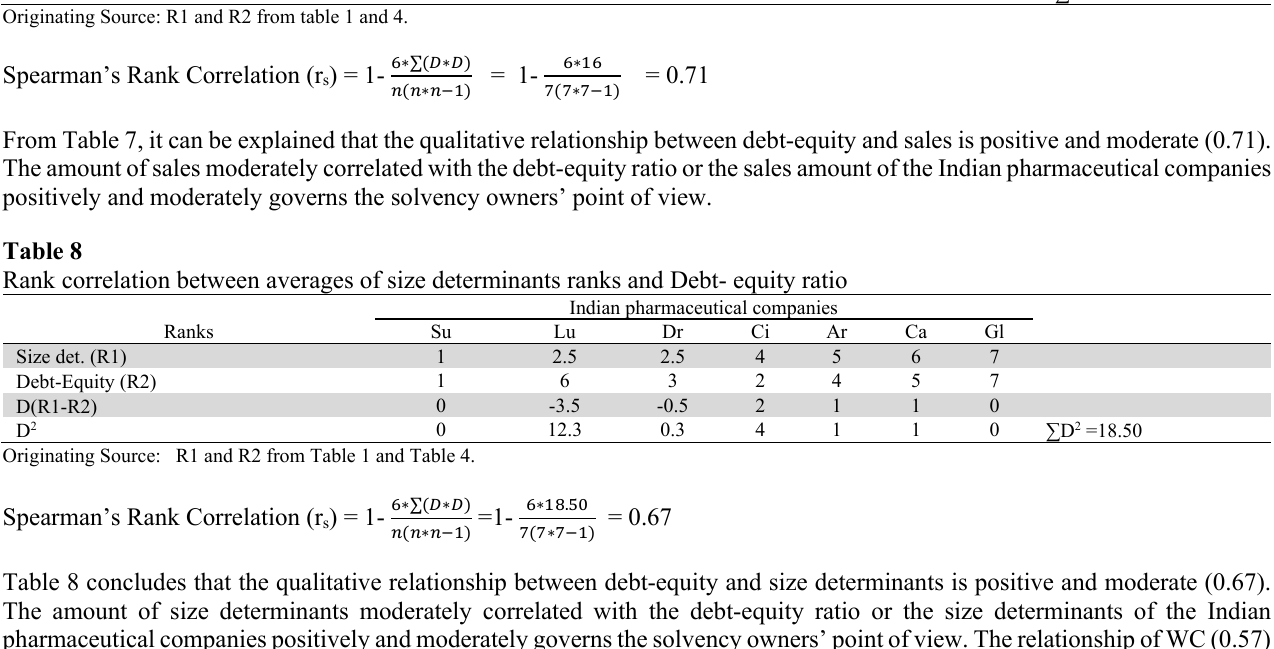
Table 8 concludes that the qualitative relationship between debt-equity and size determinants is positive and moderate (0.67). The amount of size determinants moderately correlated with the debt-equity ratio or the size determinants of the Indian pharmaceutical companies positively and moderately governs the solvency owners’ point of view. The relationship of WC (0.57) with the debt-equity ratio is positive but weaker than the TA (0.71) and sales (0.71) of the Indian pharmaceutical